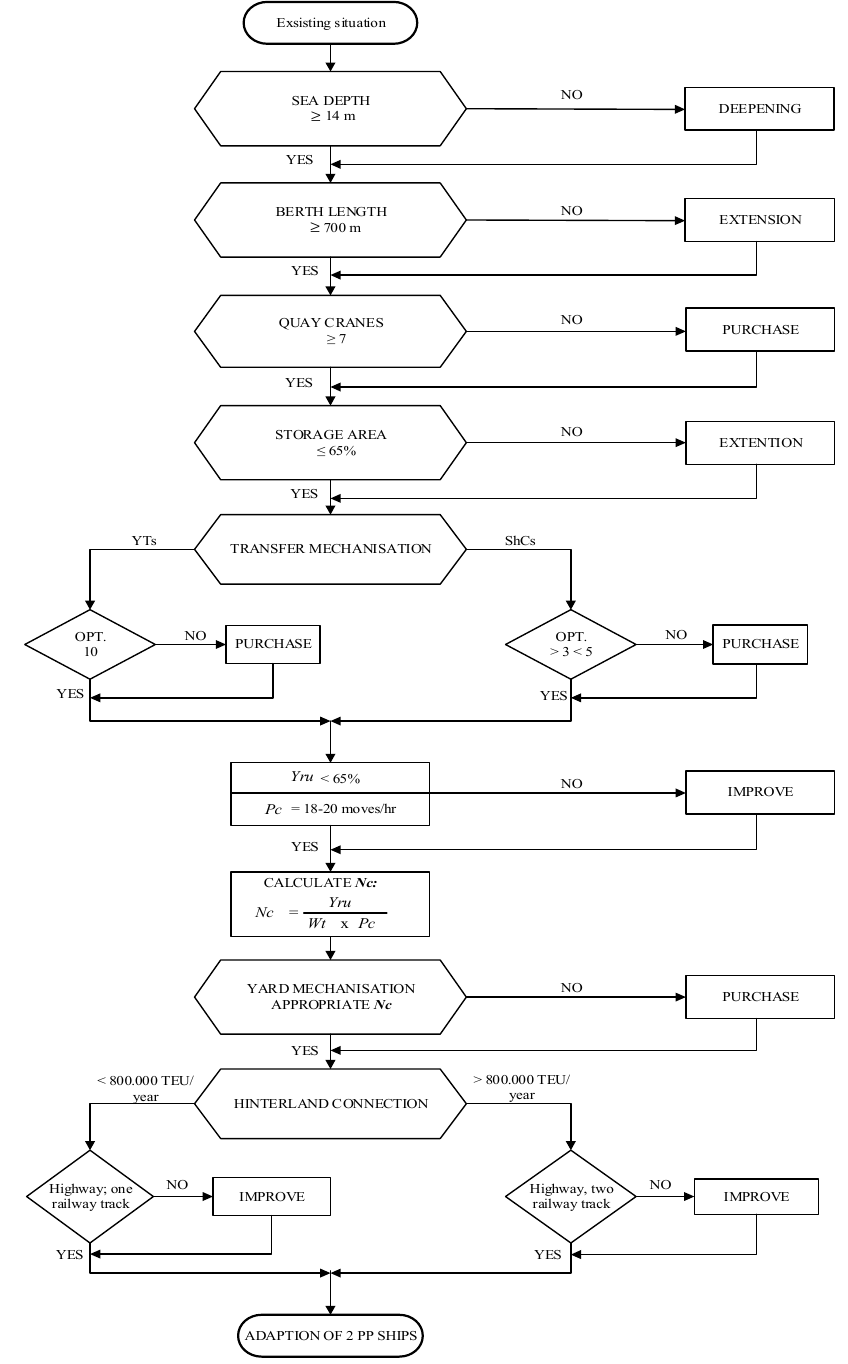
Figure 7. DST for the simultaneous acceptance of two post-Panamax ships at the terminal. * When deciding on factors: berth length and quay cranes, the minimum (3) and maximum (4) QCs per vessel must be taken into account, as well as the required distance between the two nearby QCs (25 m).